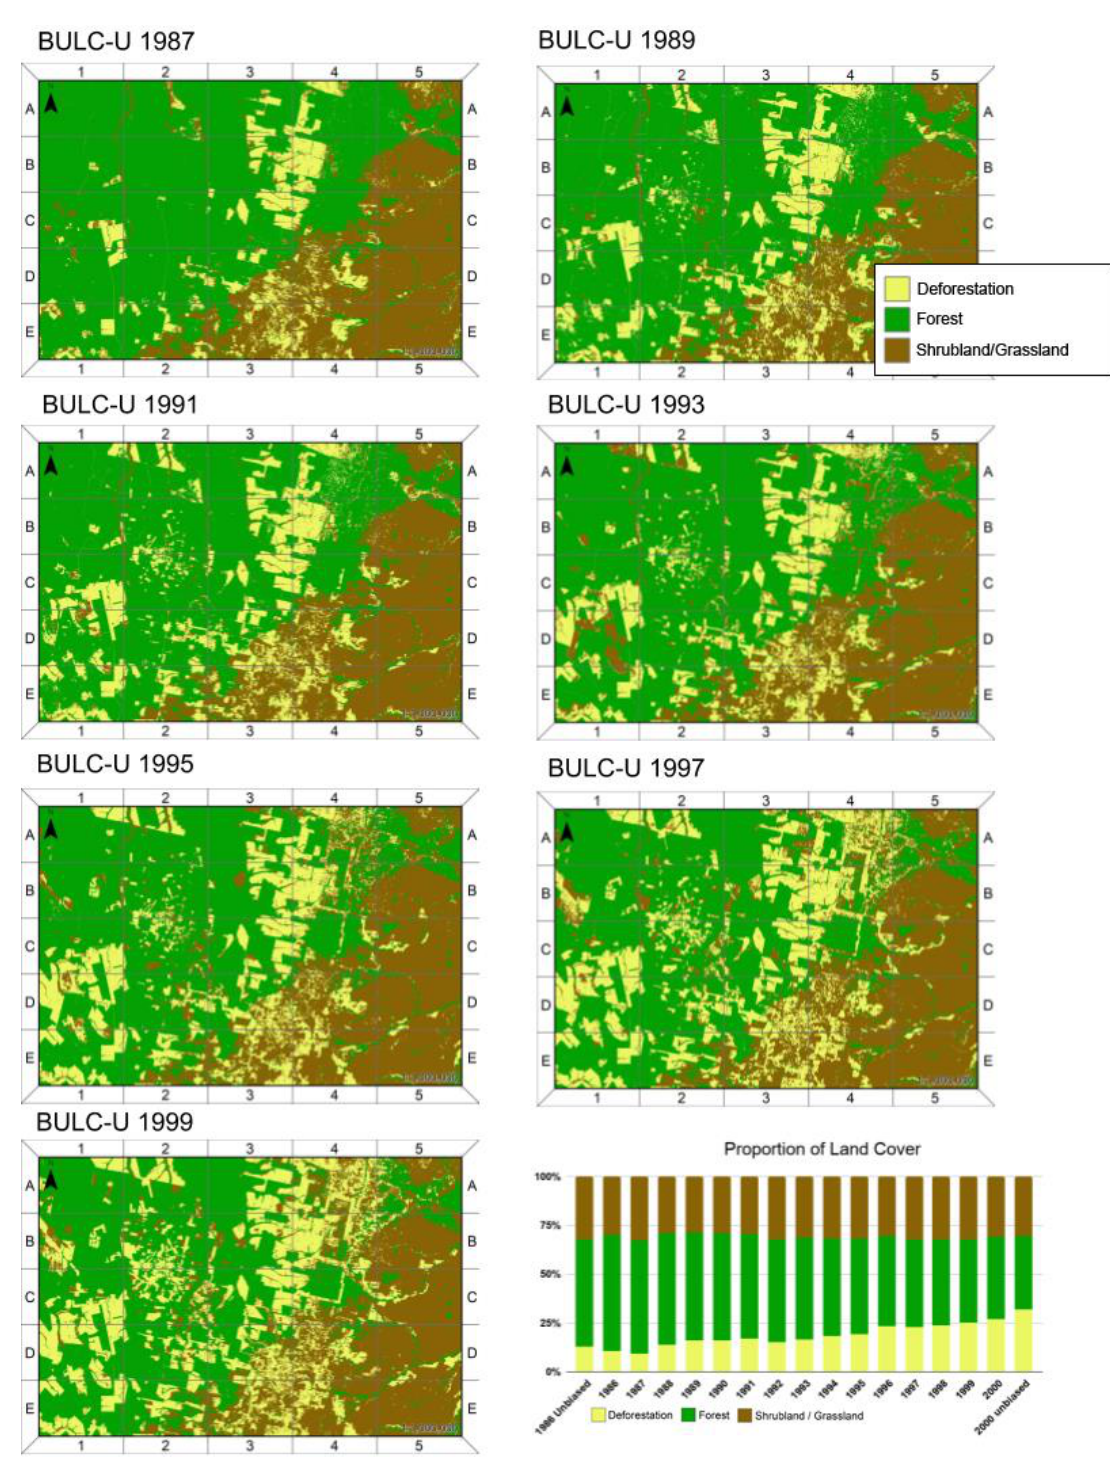
Figure 6. BULC-U classification between 1987 – 1999 and LULC proportions estimated for each